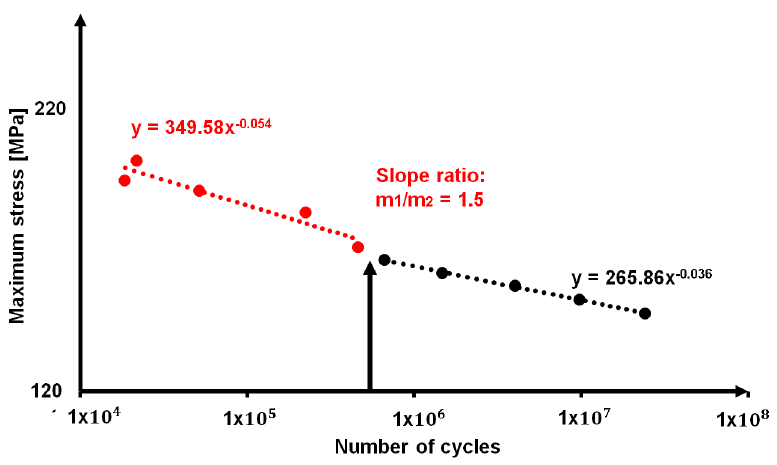
Figure 13. Persistent slip band limit provided by the results of S 1 parameters.